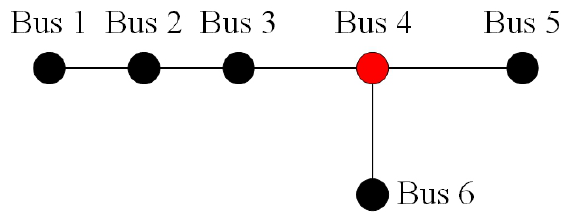
Figure 2. Example of a 6-bus system with PMU located at Bus